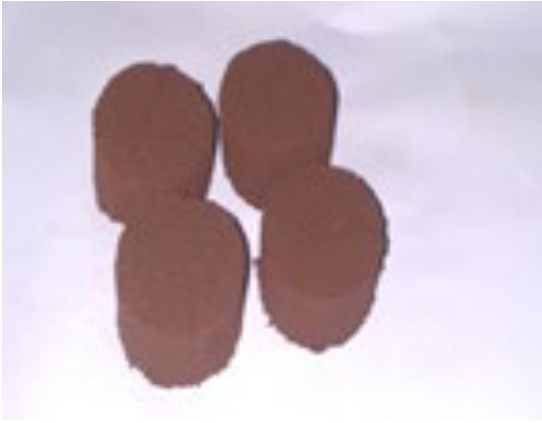
Figure 5. Preforms prepared after compaction.